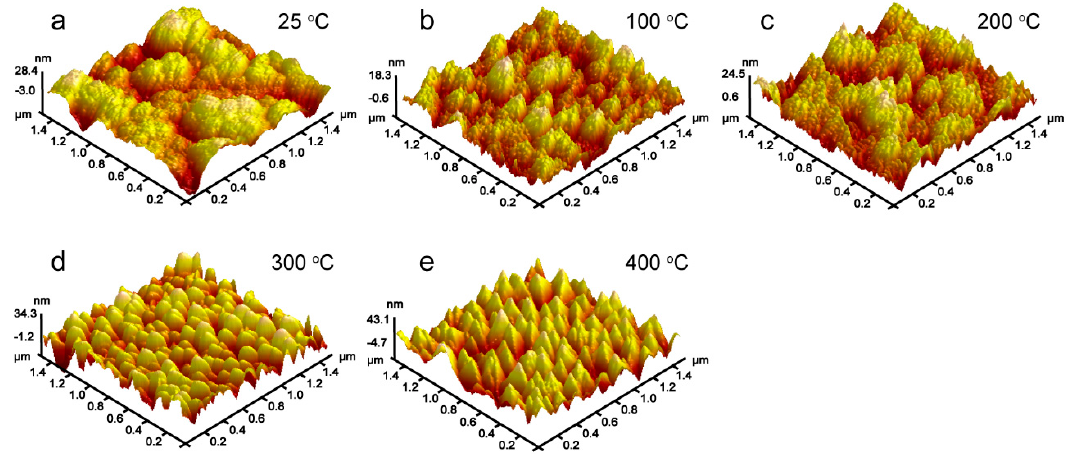
Figure 3. AFM results of V films deposited on Si (100) at D t-s = 60 mm, T s = ( a ) 25 °C, ( b ) 100 °C, ( c ) 200 °C, ( d ) 300 °C, and ( e ) 400 °C.